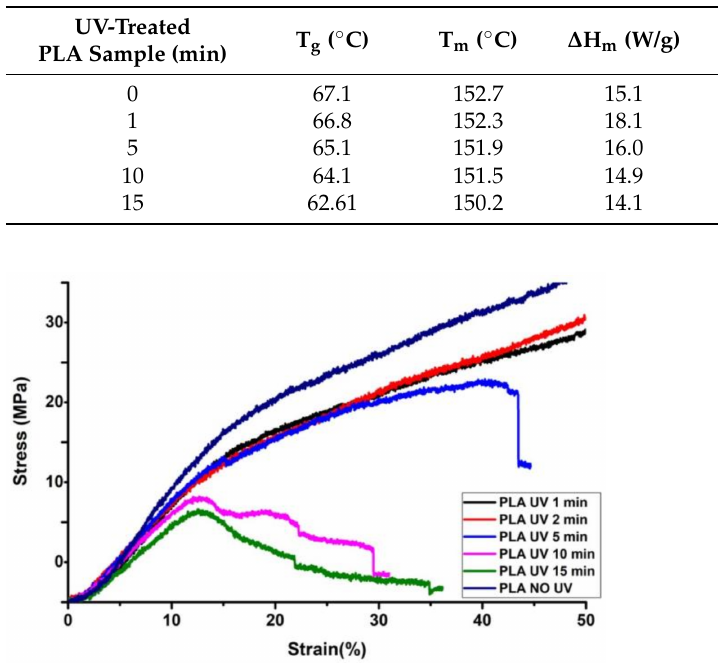
Table 3. Different properties of UV-treated PLA samples.